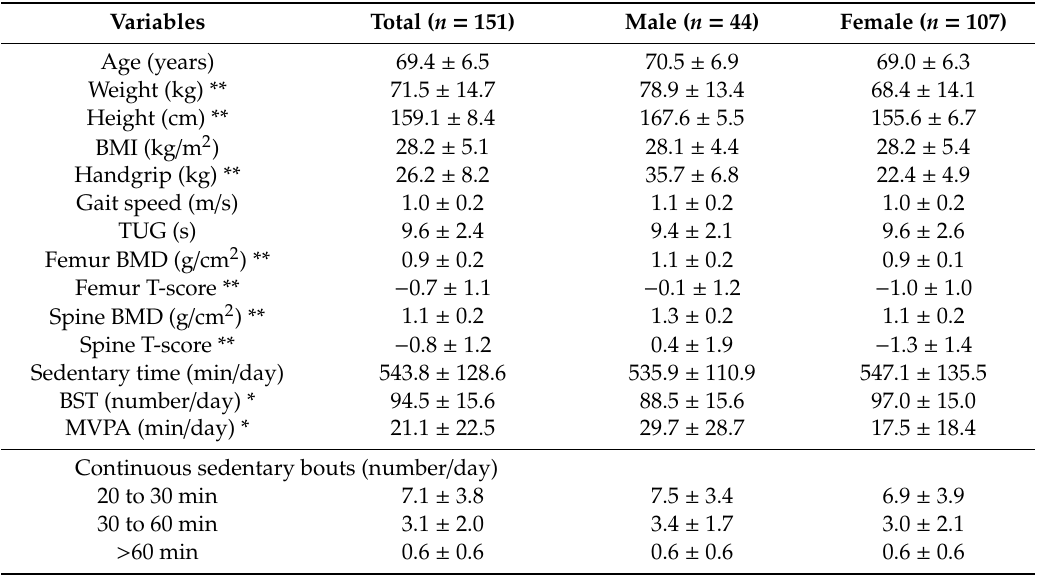
Table 1. Mean and standard deviation values for the participants’ characteristics at the baseline according to